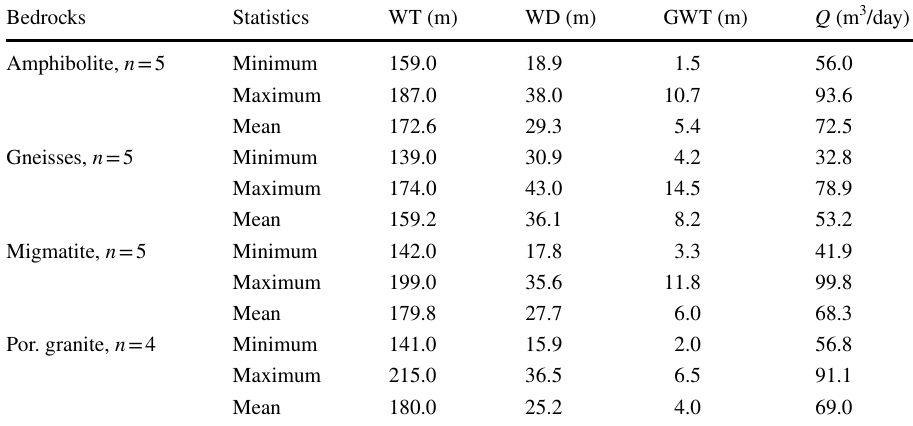
Table 4 Statistical summary of geo-electric parameters and well inventory data by